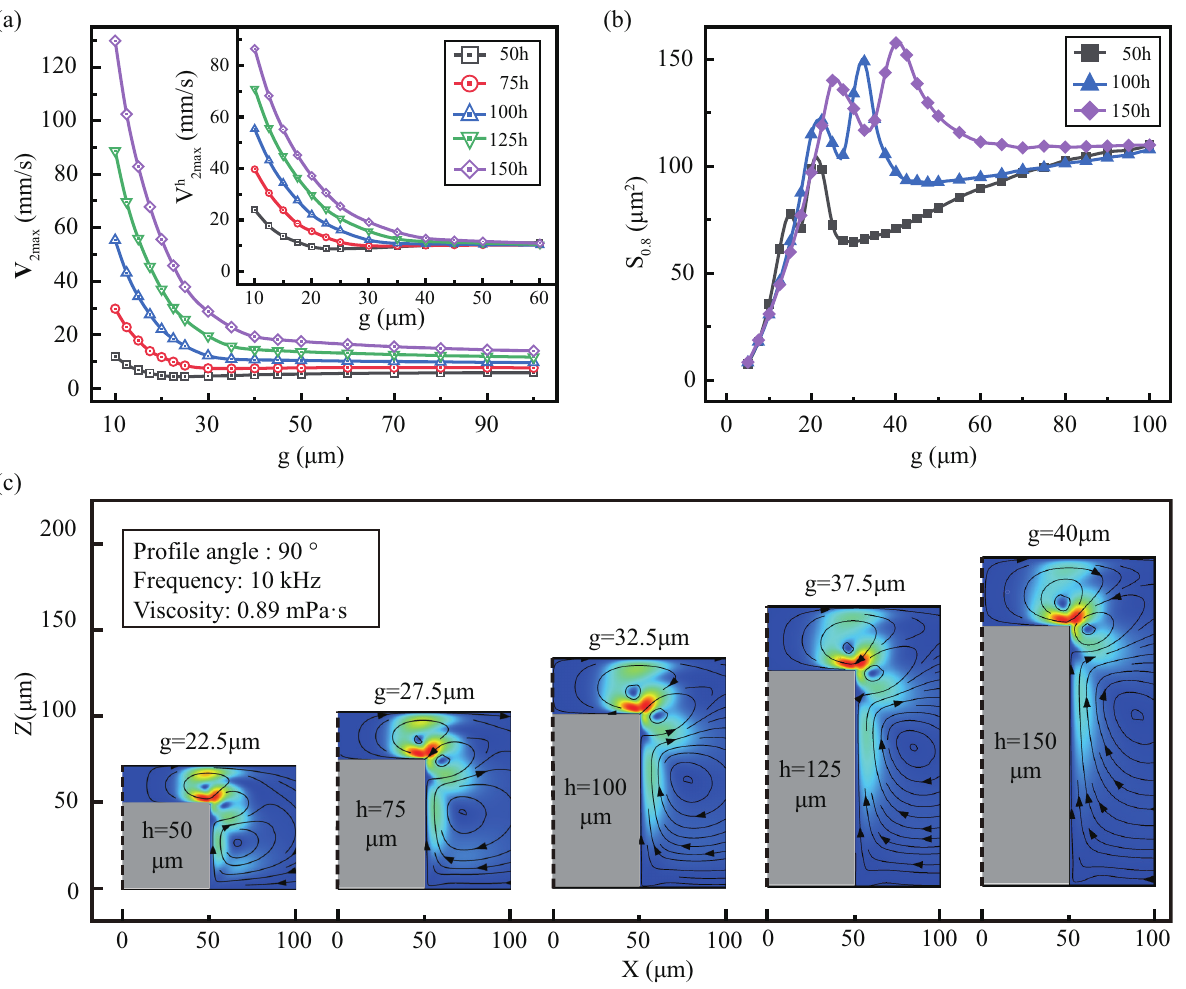
Figure 7. The effect of the gap under various h on the streaming: ( a ) the maximum streaming velocity, where the altitude equivalent velocity is displayed in the inset. ( b ) effective area S 0.8 . ( c ) streaming patterns under optimal gap, in which the black dotted line is the symmetry axis, and the gray is the